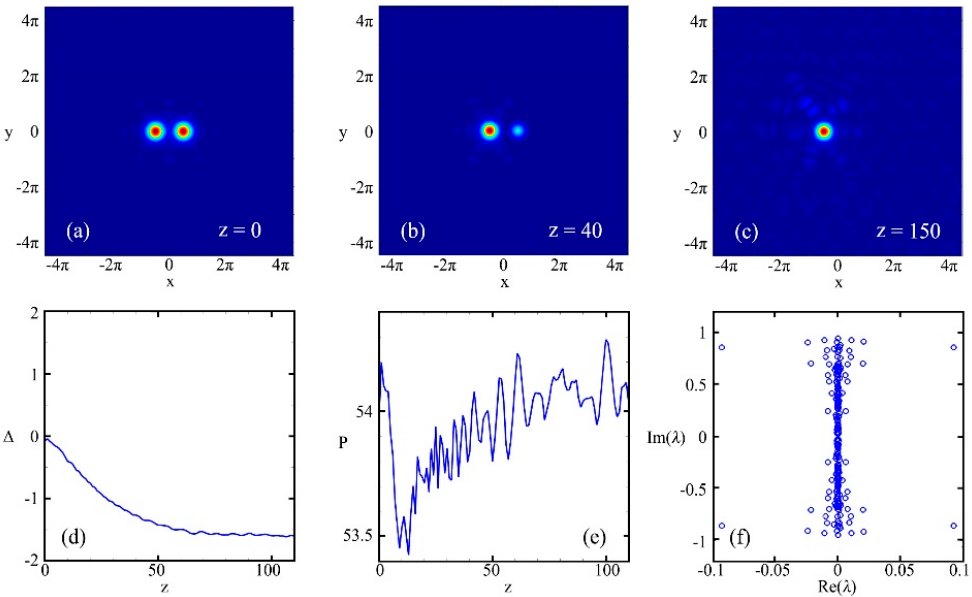
Figure 4. The dynamics of the unstable dipole soliton with d = 0.5, µ = 6. ( a – c ) correspond to the transverse profile of solitons at z = 0, z = 40, and z = 150, respectively. ( d , e ) correspond to ∆ and P during propagation, respectively. ( f ) shows the spectrum of the perturbation growth rate.